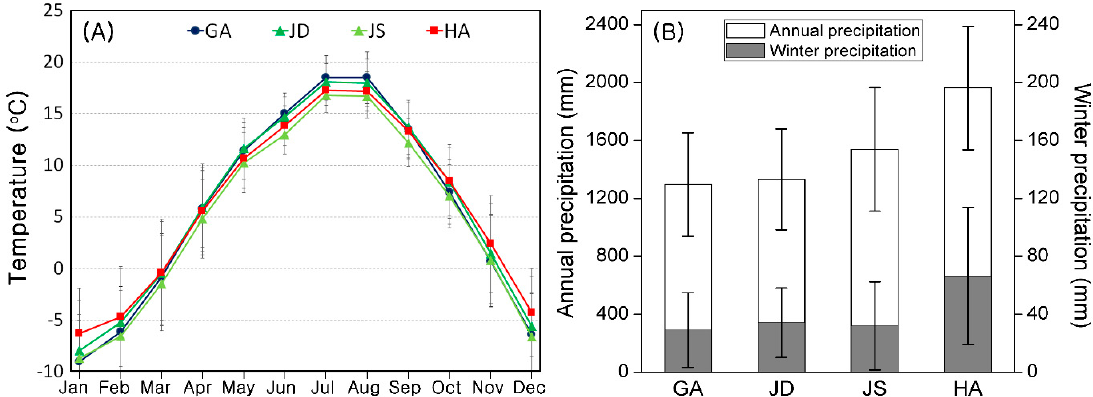
Figure 2. Monthly mean temperature ( A ) at the study sites during the period of June 2008 to June 2018. Temperatures values are estimated using the generalized least squares method considering time-series autocorrelation (Mean Absolute Error: 0.56–0.99). Annual and winter precipitation ( B ) during 1987–2017 (data from the nearest weather station of the Korea Meteorological Administration). GA: Mt. Gaya; JD: Dweajiryeong of Mt. Jiri; JS: Sesuck of Mt. Jiri; HY: Youngsil of Mt. Halla; HS: southern slope of Mt. Halla.